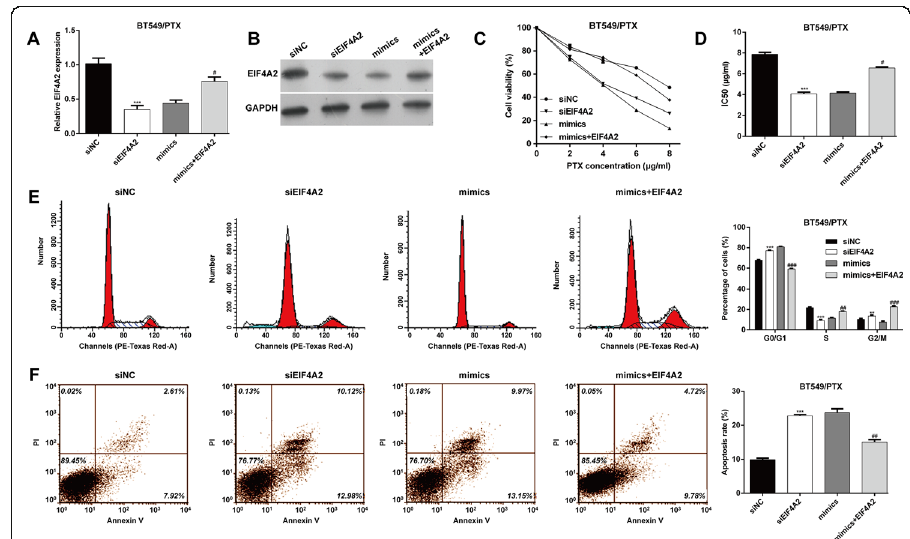
Fig. 5 MiR-5195-3p enhanced the paclitaxel sensitivity of TNBC cells by downregulating EIF4A2. BT549/PTX cells were transfected with siNC, siEIF4A2, mimics, mimics + EIF4A2, respectively. a and b Quantitative real- time analysis and western blotting were used to determine the expression of EIF4A2 in paclitaxel-resistant BT549/PTX cells. c and d CCK-8 assay was performed to determine the IC 50 value of paclitaxel in BT549/PTX cells from different groups. e Representative images of cell cycle distribution are shown in the left panel and a statistical analysis of the cell percentage in G0/G1, S and G2/M phases is shown in the right panel. f Representative images of apoptosis are shown in the left panel and a statistical analysis of apoptosis is shown in the right panel. *** p < 0.001 vs. siNC; # p < 0.05, ## p < 0.01, ### p < 0.001 vs.